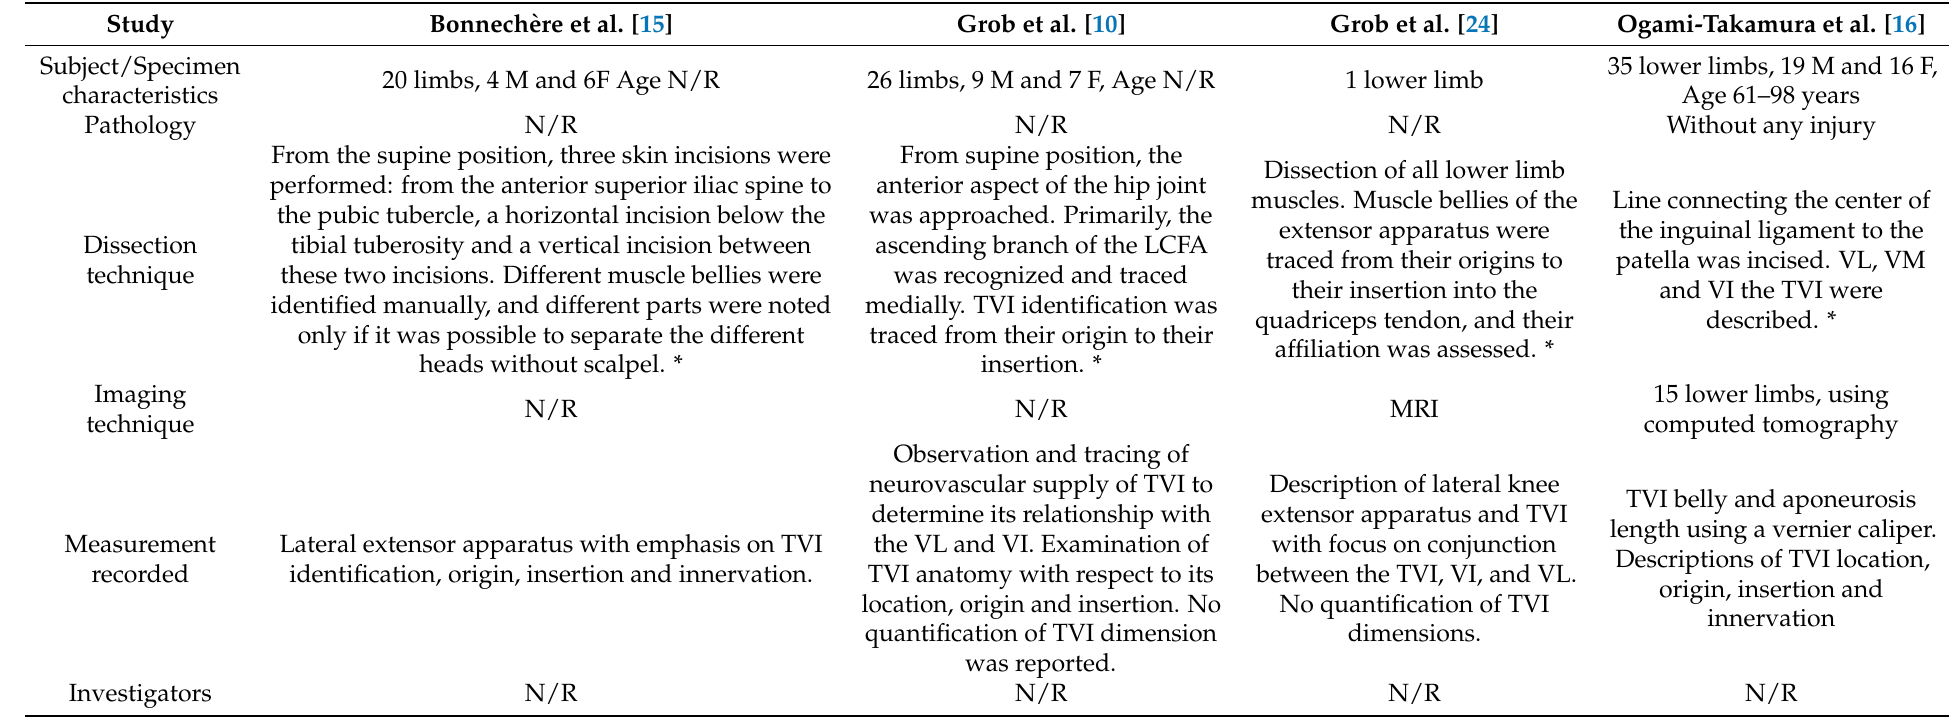
Table 1. Summary of the papers included in this systematic